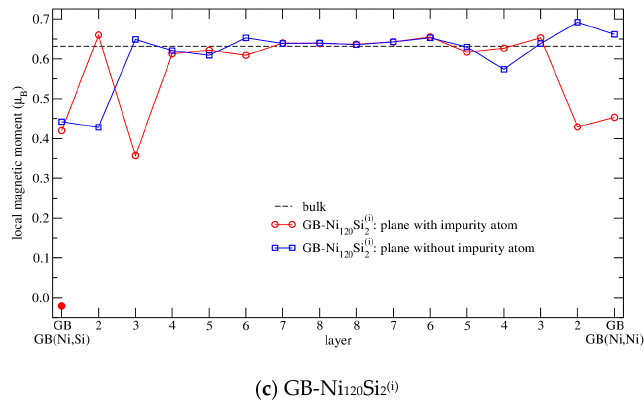
Figure 5. The dependence of magnetic moment of Ni atom on the number of the atomic layer: ( a ) GB-Ni 120 , ( b ) GB-Ni 118 Al 2(s) , ( c ) GB-Ni 120 Si 2(i) . The violet line with diamonds corresponds to the Σ 5(210) GB in elemental fcc Ni. The blue (red) line with squares (circles) corresponds to the planes without (with Al or Si) impurity, which are parallel to the plane of paper in structures shown in Figure 3. The exact meaning of expression plane is defined in the text above. GB(X,Ni) denotes the GB with impurity X (X = Al (s) , Si (i) ) and GB(Ni,Ni) the clean GB. The lines do not reflect any physical meaning; they are used to guide the eye only. The dashed line shows the magnetic moment of fcc bulk Ni of 0.632 μ B calculated in this work. The full red circle corresponds to the magnetic moment of Al (Si) impurity. This figure does not contain the system GB-Ni 118 Si 2(s) as it provides results similar to data presented for system GB-Ni 118 Al 2(s) in part ( b ). For a better demonstration of results in case of (b) and ( c ), the plane with impurity atom is always presented so that there is an impurity on the left part of the figures. This was achieved by the shift of lines representing the results of some planes with impurities (the middle plane of GB-Ni 118 Al 2(s) or the second plane of GB-Ni 120 Si 2(i) ) and one without impurity (the middle plane of GB-Ni 120 Si 2(i) ) by ½ of the lattice parameter b .